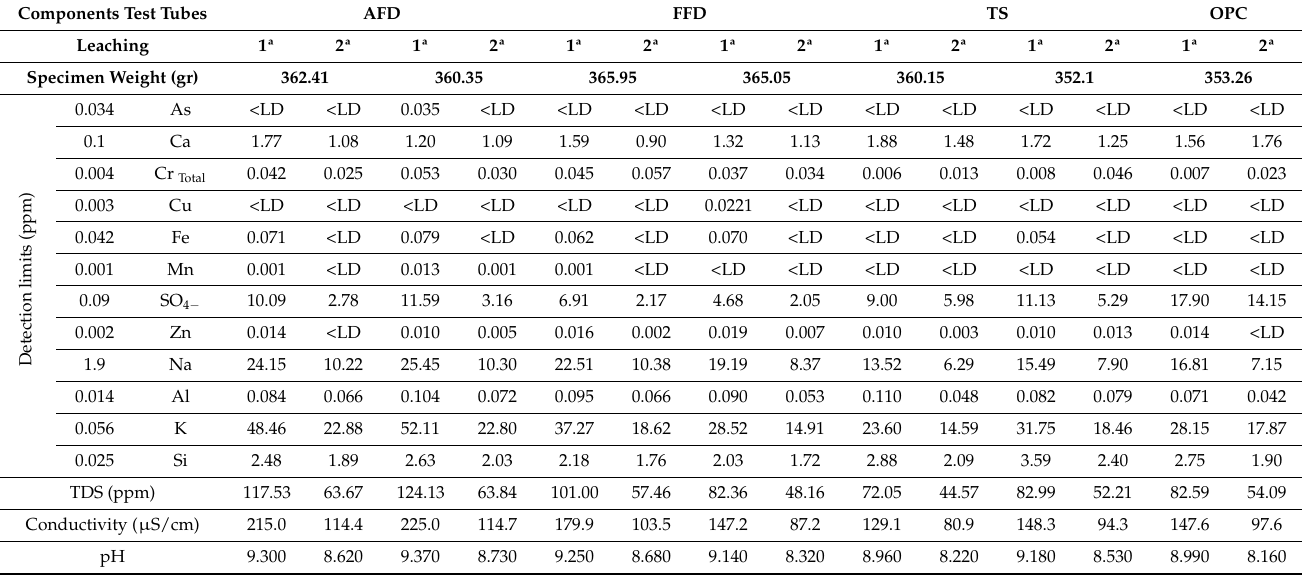
Table 6. Analysis of leachate concentration